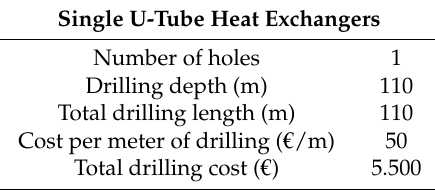
Table 6. Calculation of the geothermal drilling by the software “Earth Energy Designer” using single U-tube heat exchangers. Value provided by the Spanish company “Sondeos